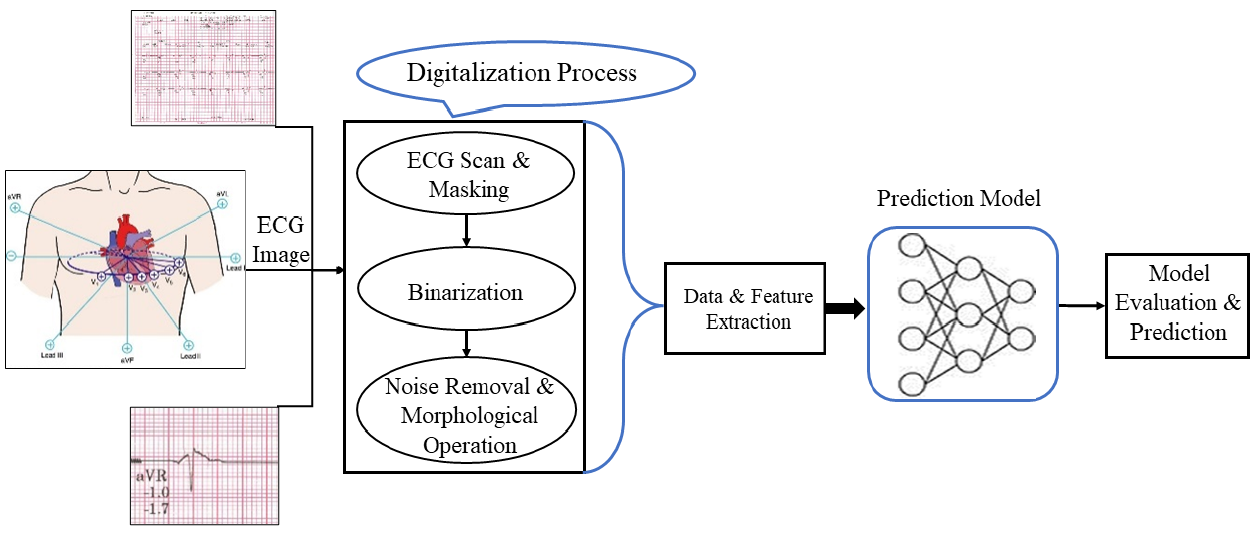
Figure 2. The 12-lead TMT-ECG end-to-end architecture for ECG prediction.